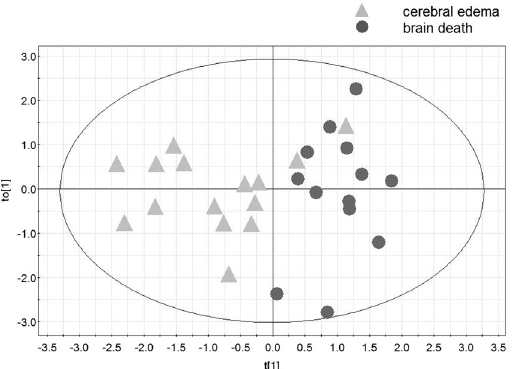
Figure 3. Orthogonal partial least squares-discriminant analysis (OPLS-DA) scores plot of ICG inflow and outflow variables showing separation between the two groups: patients with posttraumatic cerebral edema and those with brain death (model 2). t o [1] represents within-class variation in the first orthogonal component, while t[1] represents between-class variation in the first predictive component. The ellipse represents Hotelling T 2 with 95% confidence in the scores